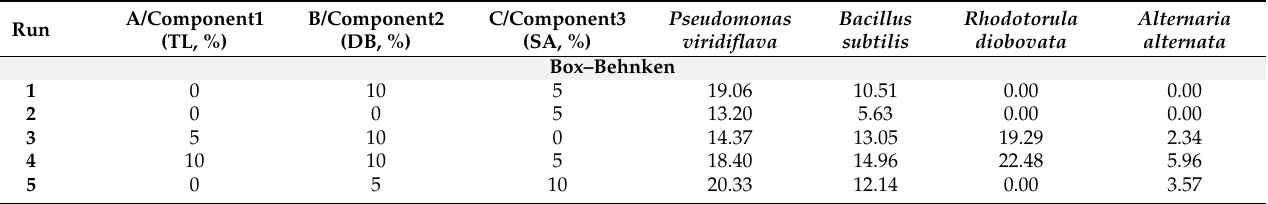
Table 2. Experimental matrix for Box–Be hnken and Simplex–Lattice mixture designs and mean values of responses ( n = 3) for inhibition zone (mm) of extract blends against the studied